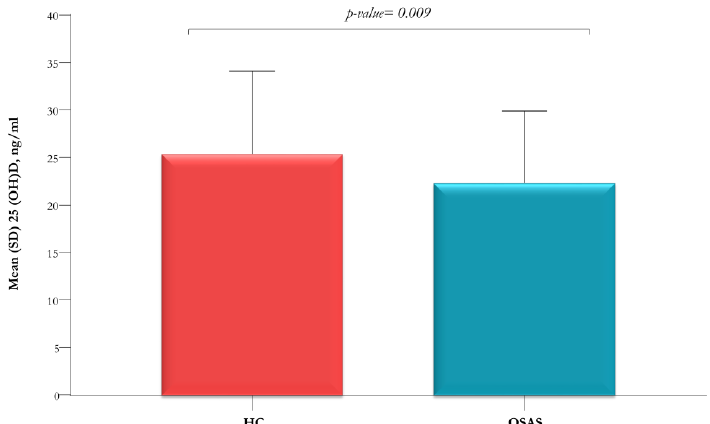
Figure 1. Serum vitamin D levels in OSAS patients ( n = 96) and in age-matched healthy controls (HC) ( n = 96). Table 2. Demographic and auxological data and serum 25(OH)D levels for OSAS patients and healthy controls (HC) matched by age.